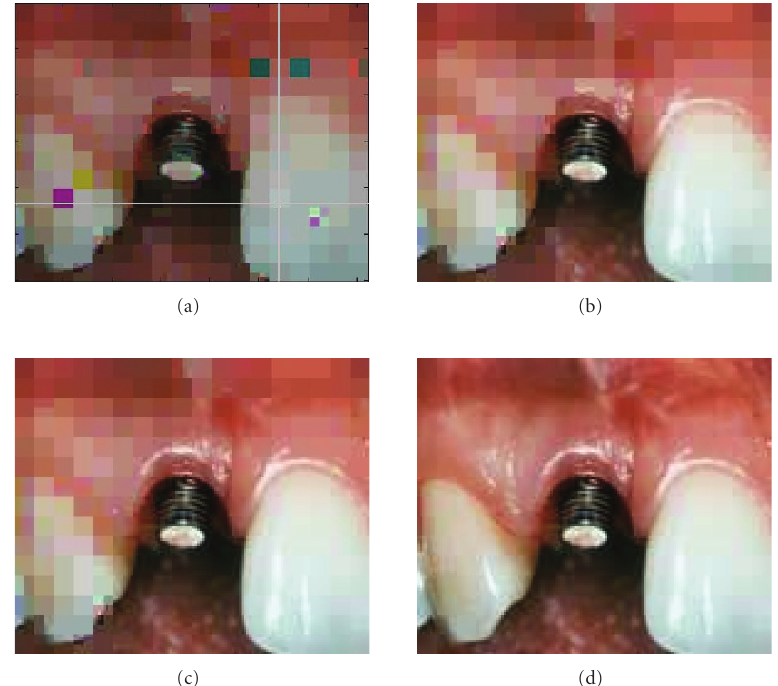
Figure 10: Similar results as in Figure 9 when the RoI is selected in the corner of the